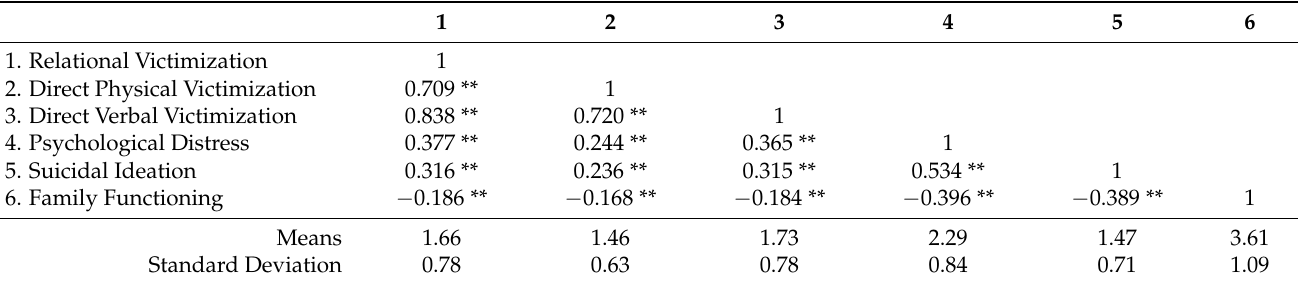
Table 1. Pearson correlations, means, and standard deviations.